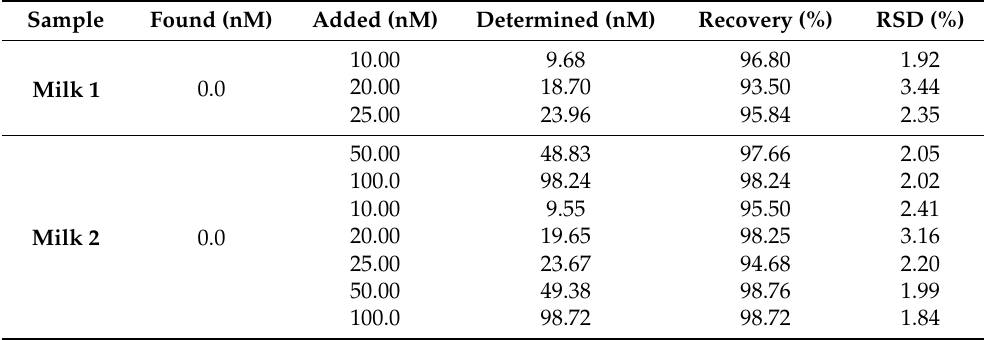
Table 1. Results of OTC determination in two different real samples using the proposed electrochemi- cal